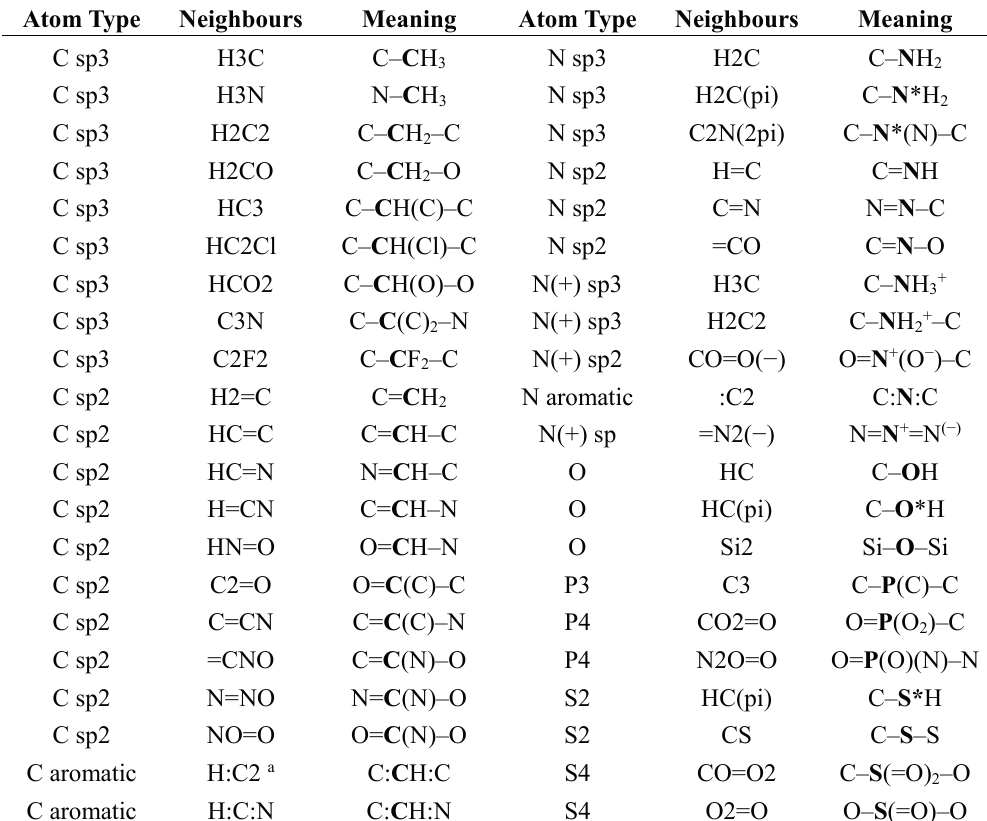
Table 1. Group examples and their